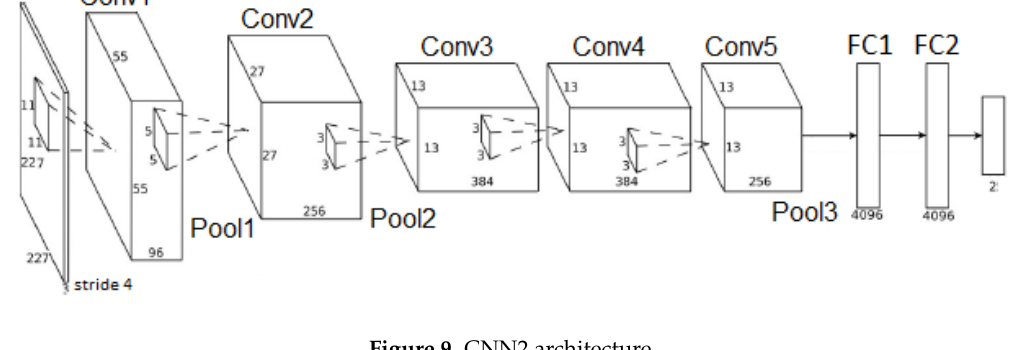
Figure 9. CNN2 architecture. Table 2. CNN2 architecture